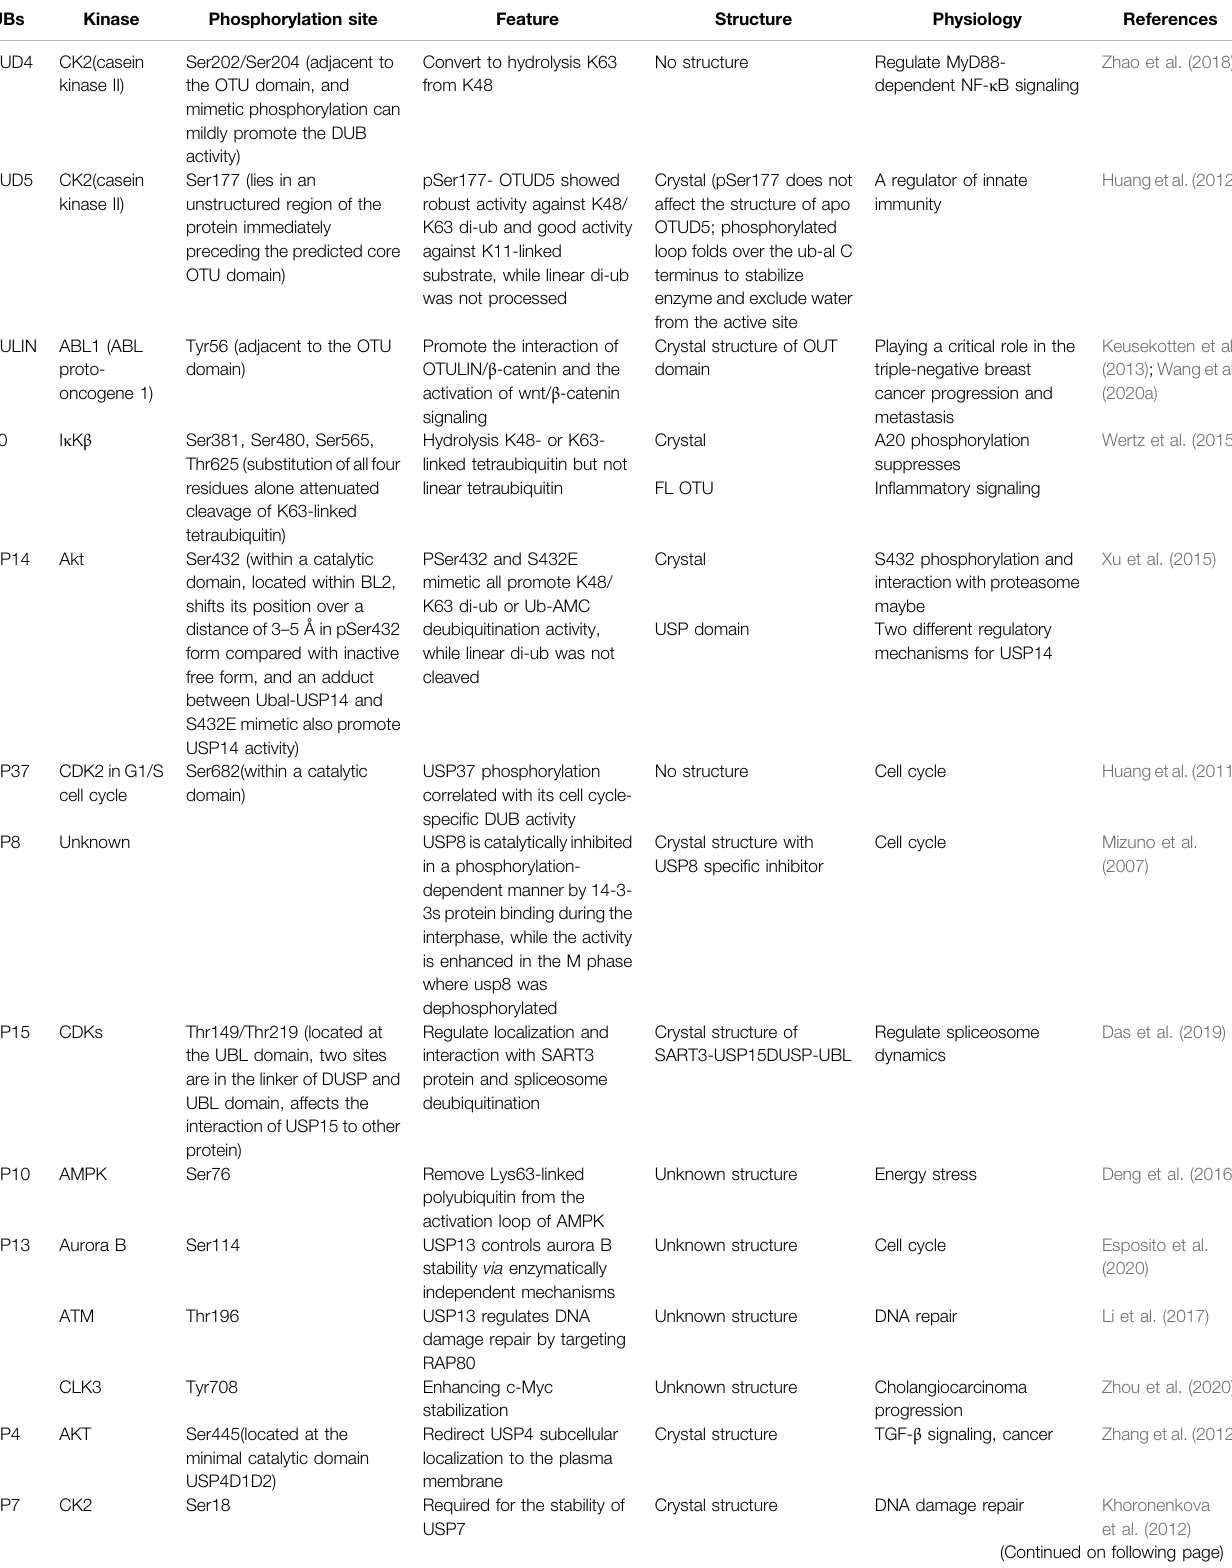
TABLE 2 | Summary of phosphorylation induced DUBs ’ activity